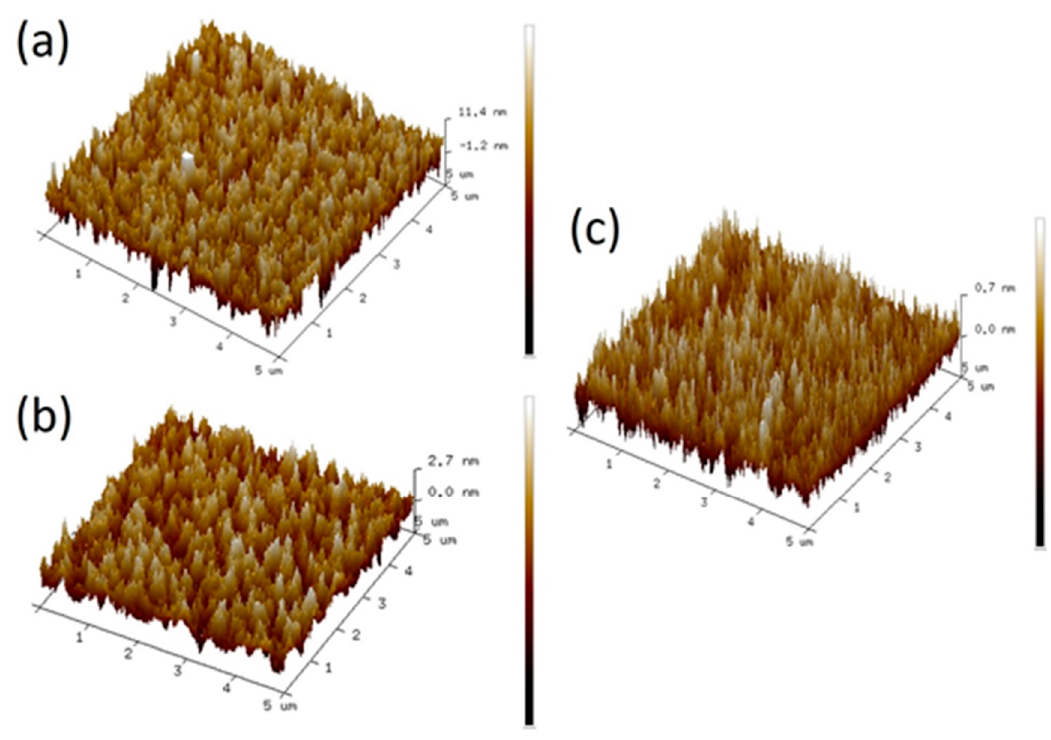
Figure 2. The surface morphologies at ( a ) SZO, ( b ) BZO, and ( c ) MZO thin films for AFM images.